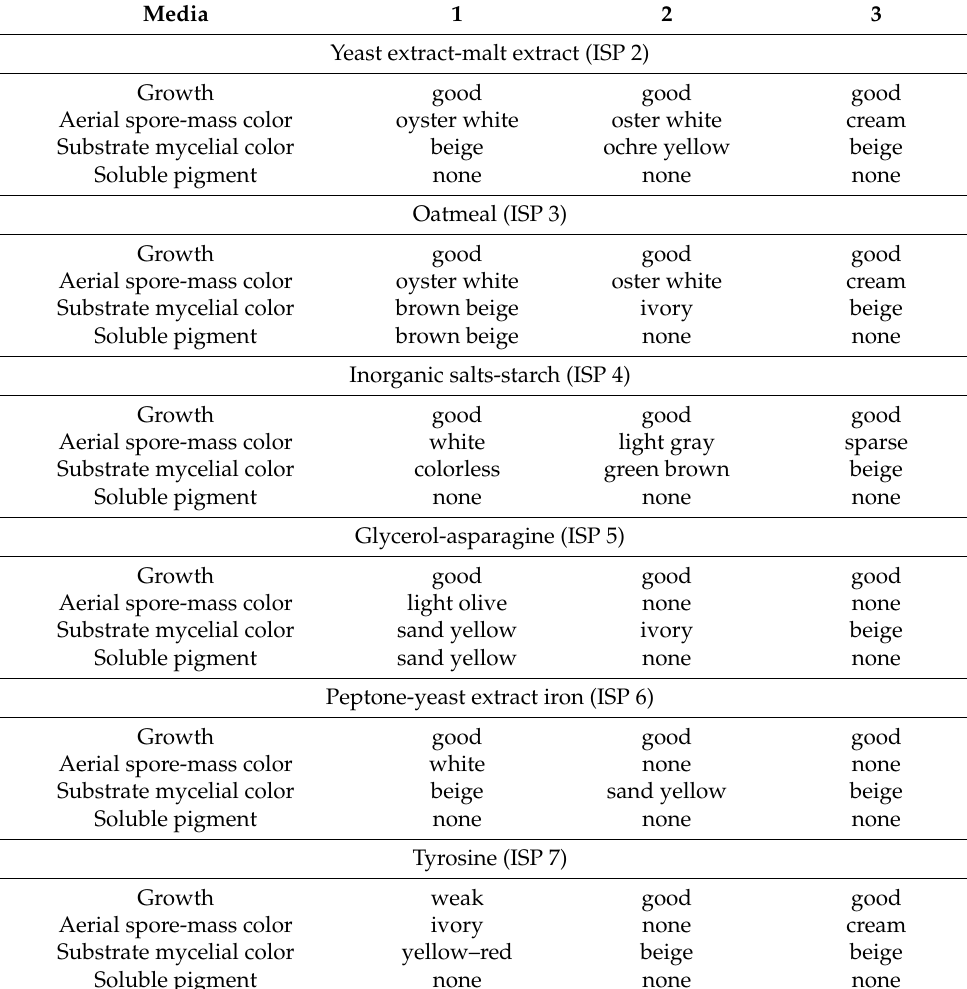
Table 2. Cultural characteristics of strain 4-3 (1) and closely related Streptomyces globisporus subsp.